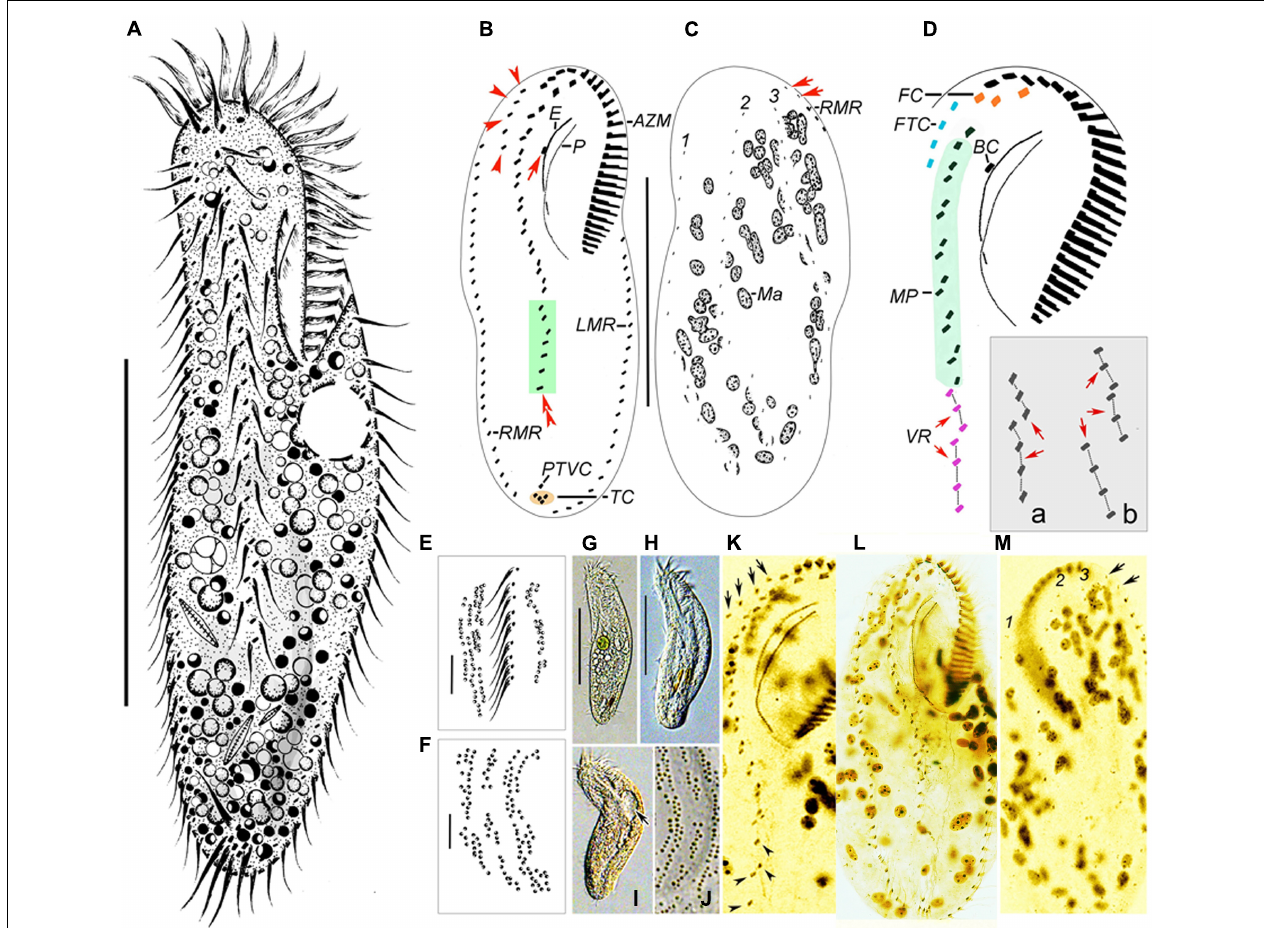
FIGURE 4 | Morphology of Bakuella xianensis n. sp. from life (A, E–J) and after protargol staining (B–D,K–M) . (A) Ventral view of a representative specimen. (B,C) Ventral (B) and dorsal (C) views of the holotype specimen to show the infraciliature and nuclear apparatus. In (B) , arrow marks the buccal cirrus, arrowheads show the frontoterminal cirri, and double arrowheads mark a short ventral row (in green box). In (C) , arrows indicate the basal body pairs ahead of the right marginal row. (D) Ventral view to show details of buccal field and midventral complex; inset (a,b) shows two different arrangements of ventral rows (VR, arrows). (E,F,J) Detail of distribution of cortical granules in irregular longitudinal rows on ventral (E) and dorsal (F,J) sides. (G–I) Ventral views to show different body shapes due to flexibility of cells. Arrow indicates the contractile vacuole. (K) Ventral view to show details of buccal field and midventral complex, arrows show the frontoterminal cirri, and arrowheads indicate the midventral rows. (L,M) Ventral (L) and dorsal (M) views of the same specimen showing infraciliature and nuclear apparatus. Arrows indicate the basal body pairs ahead of right marginal row. AZM, adoral zone of membranelles; BC, buccal cirrus; CV, contractile vacuoles; E, endoral; FC, frontal cirri; FTC, frontoterminal cirri; LMR, left marginal row; Ma, macronuclear nodules; MVP, midventral pairs; P, paroral; PTVC, pretransverse ventral cirri; RMR, right marginal row; TC, transverse cirri; VR, ventral row; 1–3, dorsal kineties. Scale bars: (A–C,G,H) = 60 µ m, (E,F) = 7 µ